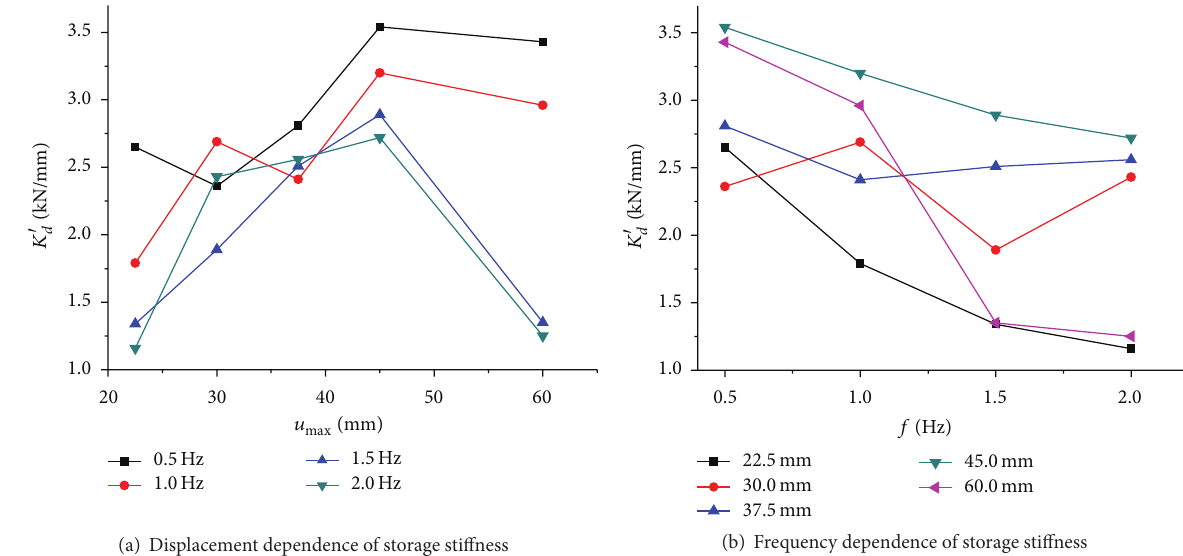
Figure 6: The characteristics of the storage